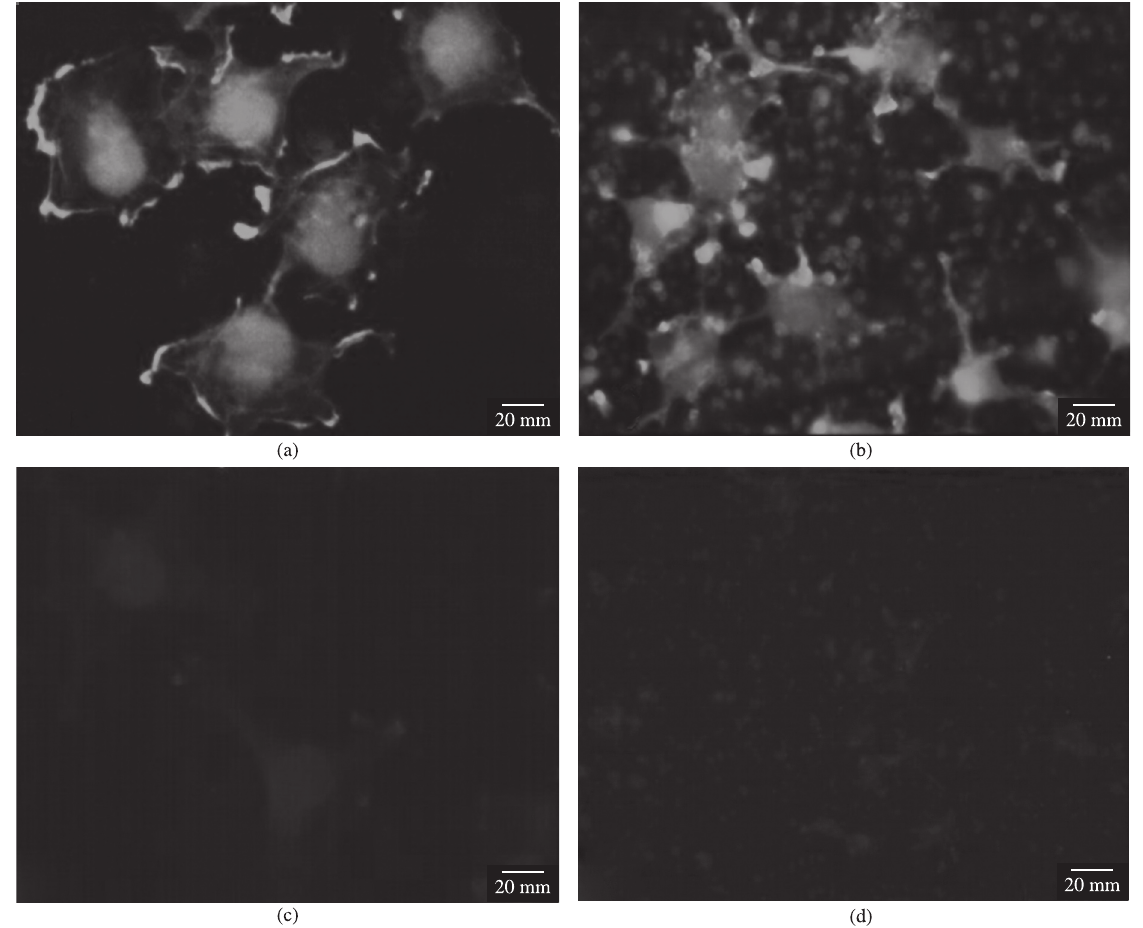
Figure 5. Optical images of cytoskeletal immunofluorescence of the osteoblasts cells cultured onto control corning glass (a, c) and onto ZnAl On control cultures the osteoblasts showing a circular and lenticular morphology of the cytoskeleton (a) and on experimental cultures osteoblasts cells showing a flattened and spreaded cell morphology indicated that cell cytoskeleton is oriented along the grooves of the nanostructure ceramic films (b). Negative controls of the immunofluorescence assay for both control (c) and experimental culture